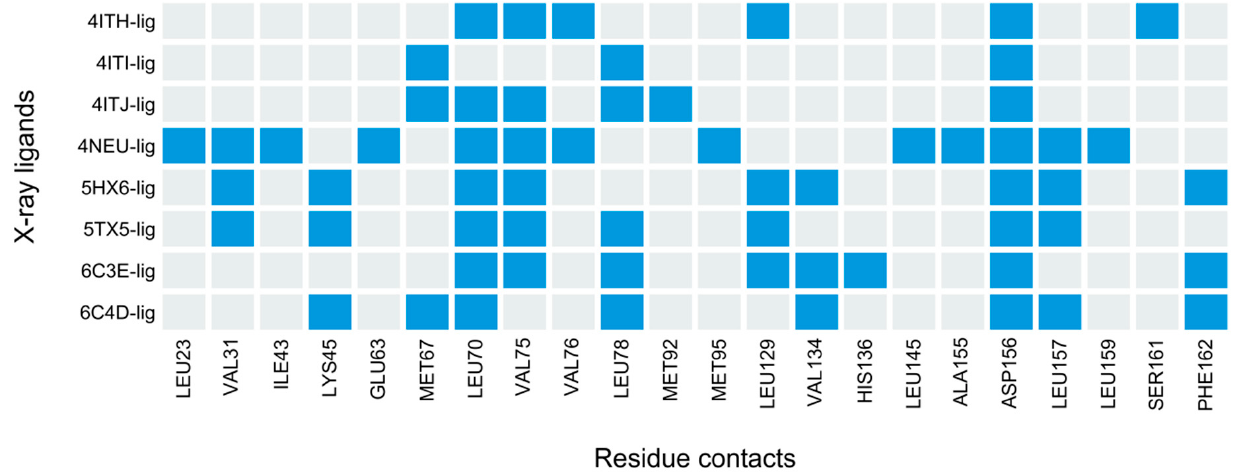
Figure 7. PLIF signatures for all X-ray ligands, where blue indicates the presence of contact of any kind between a residue and each ligand, and grey indicates the absence of interaction.